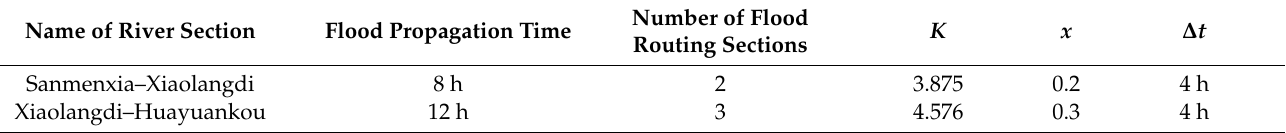
Table 2. Relevant parameters.